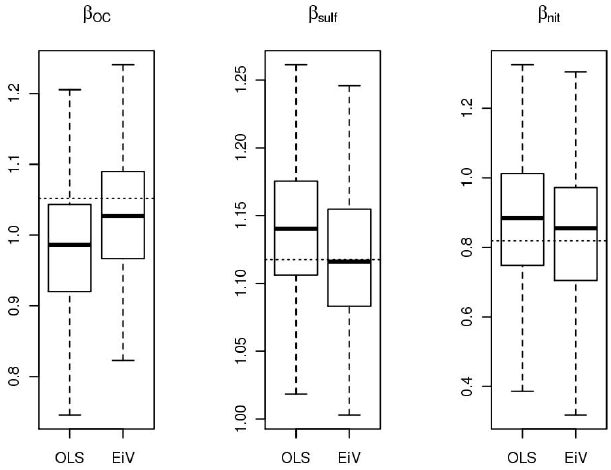
Fig. 2. Bias in regression coefficients caused by measurement er- ror in synthetic datasets representative of Gila Wilderness, NM in quarter 1. Horizontal dotted lines represent the “true” value of each coefficient. The left box in each panel illustrates bias for OLS re- gressions and the right box shows a greatly reduced bias after im- plementing the errors-in-variables (EiV) regression